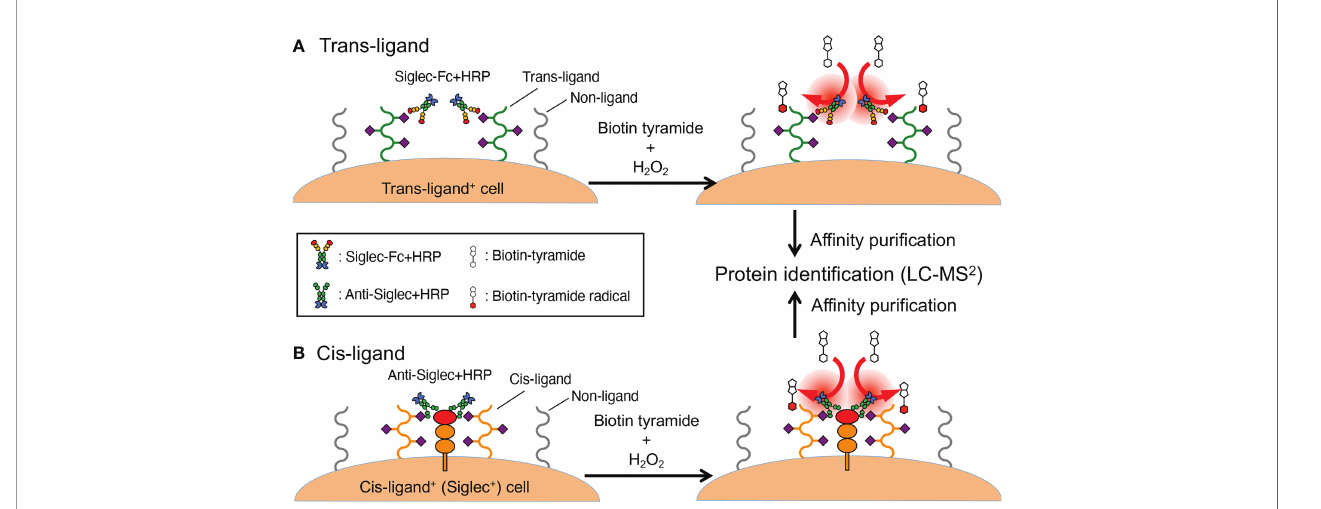
FIGURE 2 | Proximity labeling method. (A) A work fl ow to identify trans-ligands. Cells that express Siglec ligand (as revealed by fl ow cytometry, microscopy, etc.) are labeled with a recombinant Siglec of interest that is coupled to peroxidase (either as a fusion protein or by way of complexing with a secondary reagent). The cells are washed and then exposed to biotin tyramide and hydrogen peroxide, which generates short-lived tyramide radicals that diffuse a limited distance from the origin before reacting with tyrosine residues in the vicinity (or diminish). This limited diffusion distance ensures selective labeling of the proteins in the proximity of the Siglec ligand, to which the Siglec – peroxidase complex is attached. (B) A work fl ow to identify cis-ligands. The probe used in this work fl ow is not recombinant Siglec but a peroxidase-coupled antibody that recognizes the Siglec of interest. Otherwise, the overall work fl ow is similar to (A) . In fact, the work fl ow described in (A) can also be applied for the identi fi cation of